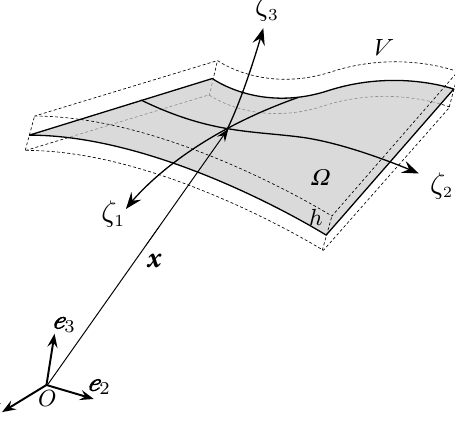
Figure 1. Schematic geometry of the solid-shell